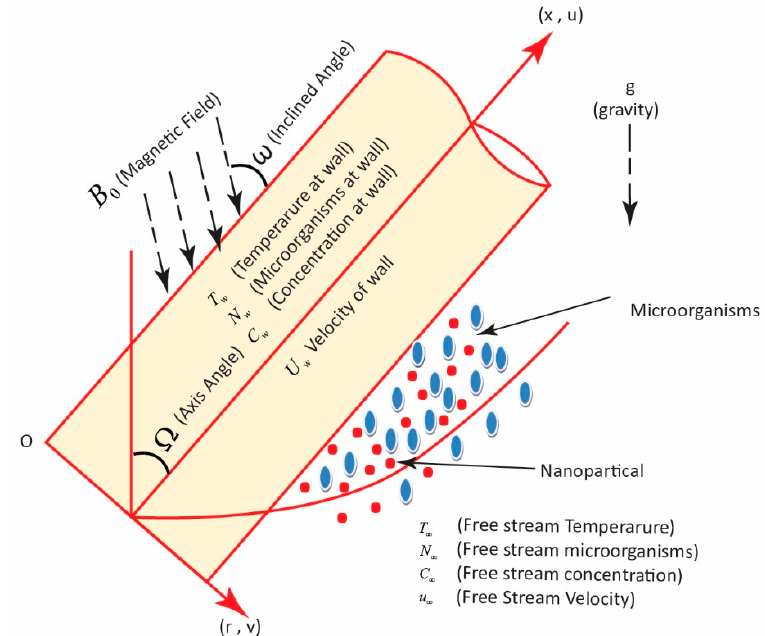
Figure 1. Physical configuration.